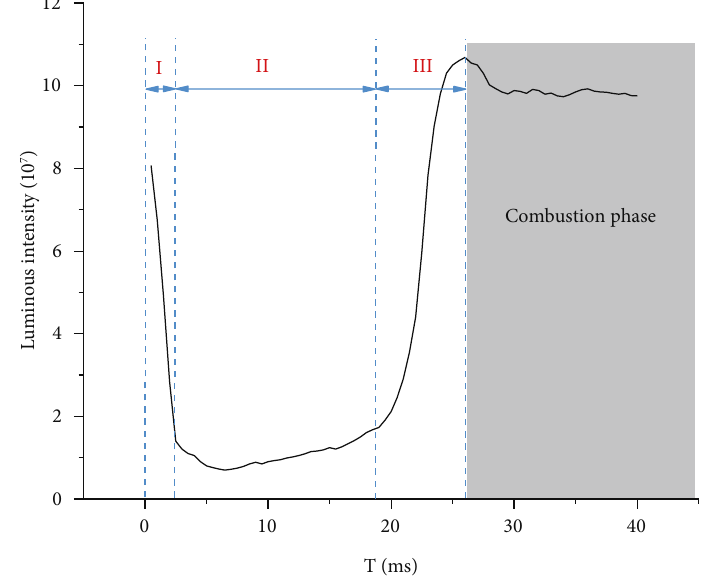
Figure 8: Variation of the integral f illumination intensity with time. Table 5: Ignition times under di ff erent operating